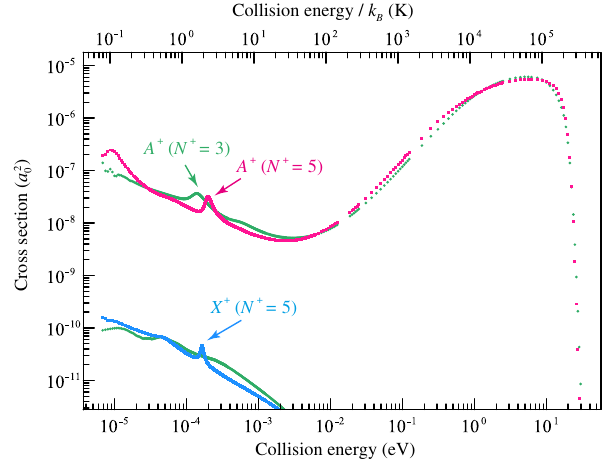
FIG. 8. Radiative-association cross sections as a function of the collision energy for D þ þ D ð 1 s Þ approaching in the i ¼ A þ (red) or i ¼ X þ (blue) entrance channel. The corresponding cross sections for H þ þ H ð 1 s Þ (green) are shown for comparison.